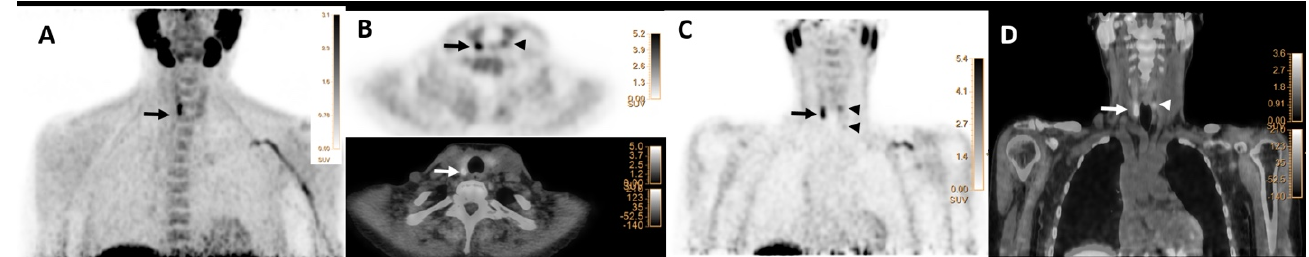
Figure 1. [ 18 F]FCH PET/CT images ( A – D ) in a 67-year-old woman with elevated serum PTH of 102 pg/mL (normal value = 16–65) and calcium level of 2.67 mmol/l (normal value = 2.13–2.63), respec- tively. ( A ) Maximum intensity projection (MIP) shows an elongated focus of tracer uptake cranial to the right thyroid lobe (arrow). ( B ) transaxial PET (upper row) and hybrid PET/CT (lower row) images show focal tracer uptake posterior to the lower pole of the right thyroid lobe with SUV max of 8.3, mSAD = 5.5mm (arrows). Another mild focal uptake, posterior to the left thyroid upper-pole with SUVmax of 3.5 and mSAD = 3.5mm (arrowheads). ( C ) Coronal PET image shows two foci of small abnormal tracer uptake posterior to the upper poles of the thyroid (arrow and superior ar- rowhead) and one additional small faint uptake (inferior arrowhead) posterior to the lower pole of the left thyroid (SUVmax = 1.85 and mSAD = 2.68mm). ( D ) The corresponding coronal hybrid PET/CT image shows the exact localization of the detected lesions (arrows). The findings are sug- gestive of multiglandular parathyroid disease verified as three parathyroid adenomas on histo- pathology.